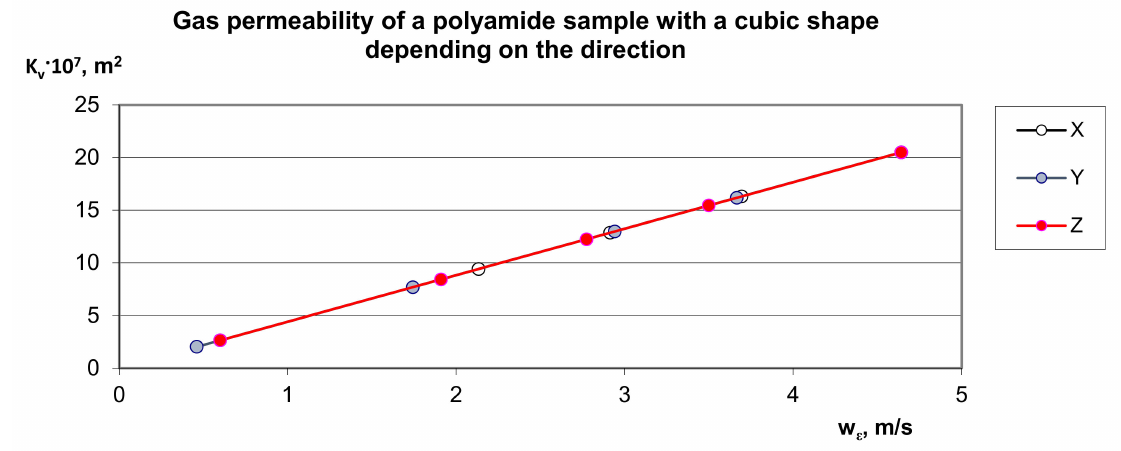
Figure 6. Distribution of experimental points characterizing the K V gas permeability coefficient through a 20 mm × 20 mm × 20 mm cubic polyamide bed with respect to the measured gas flow velocity, w ε , depending on the flow direction X, Y and